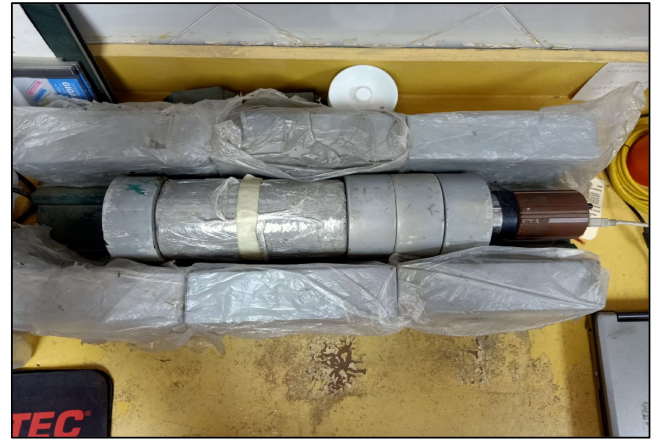
Figure 12. Attenuation shielding test.